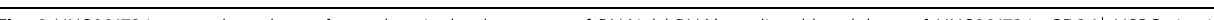
Fig. 4 LINC00173 is a novel regulator of granulocytic development. a – d RNAi (shRNA)-mediated knockdown of LINC00173 in CD34 + HSPCs in vitro. a Granulocytic in vitro differentiation (day 14). Upper panel: May-Grünwald Giemsa ( MGG ) staining; scale bars 20 µ m. Middle panel: neutrophil peroxidase ( POX ) staining; scale bar 20 µ m. Lower panel: fl ow cytometric analysis of CD66b and CD13 surface marker expression. The bar graphs (right) show the mean ± s.d. of three independent experiments. b Percentage of bead-positive cells in a phagocytosis assay. The histogram depicts the fl uorescence intensity. c Number of BFU-E and CFU-G/M (CFU-my) in methylcellulose-based CFU-assays normalized to the non-silencing shRNA control ( ctrl ). d Number of shRNA-transduced cells during granulocytic in vitro differentiation normalized to day 0. e Ratio of RFP657 + sgRNA-transduced vs. untransduced cells relative to the non-targeting control (sgRNAs against luciferase), using monoclonal NB4 cell lines stably expressing dCas-KRAB ( n = 6). f Cytoplasmic to nuclear ratio of LINC00173 determined by qRT-PCR on fractionated RNA from THP-1 cells. g RNA FISH with tiled biotinylated probes in THP-1 cells; scale bars 10 µ m. h GSEA results for 52 hematopoiesis-associated gene sets upon LINC00173 knockdown in CD34 + HSPCs. The plot shows normalized enrichment scores ( NES ) against nominal P -values of the normalized enrichment score 18 , dotted line: P = 0.05. i Heatmap showing expression of leading-edge genes from the “ Fischer_DOWN IN SEVERE APLASTIC ANEMIA ” gene set across the human DMAP data set 12 . j RIP in NB4 cells using two different antibodies, followed by qRT-PCR to detect binding of EZH2 to LINC00173 . Data are presented as percent of input in comparison to B2M . k ChIP- seq density heatmaps for H3K27me3 in promoter regions of leading-edge genes from the indicated gene sets upon LINC00173 knockdown. shRNA- transduced CD34 + HSPCs (sh-L173 and sh-CTRL) are compared to untransduced and uncultured CD34 + HSPCs. Clusters of promoters with differential H3K27me3 marks are highlighted. Representative stem cell-speci fi c genes are shown (right). Data are presented as mean ± s.d. a – f , j , or s.e.m. c , e . * P < 0.05; ** P < 0.01; ns not signi fi cant; P -values were calculated using one-way ANOVA with Dunnett ’ s post hoc